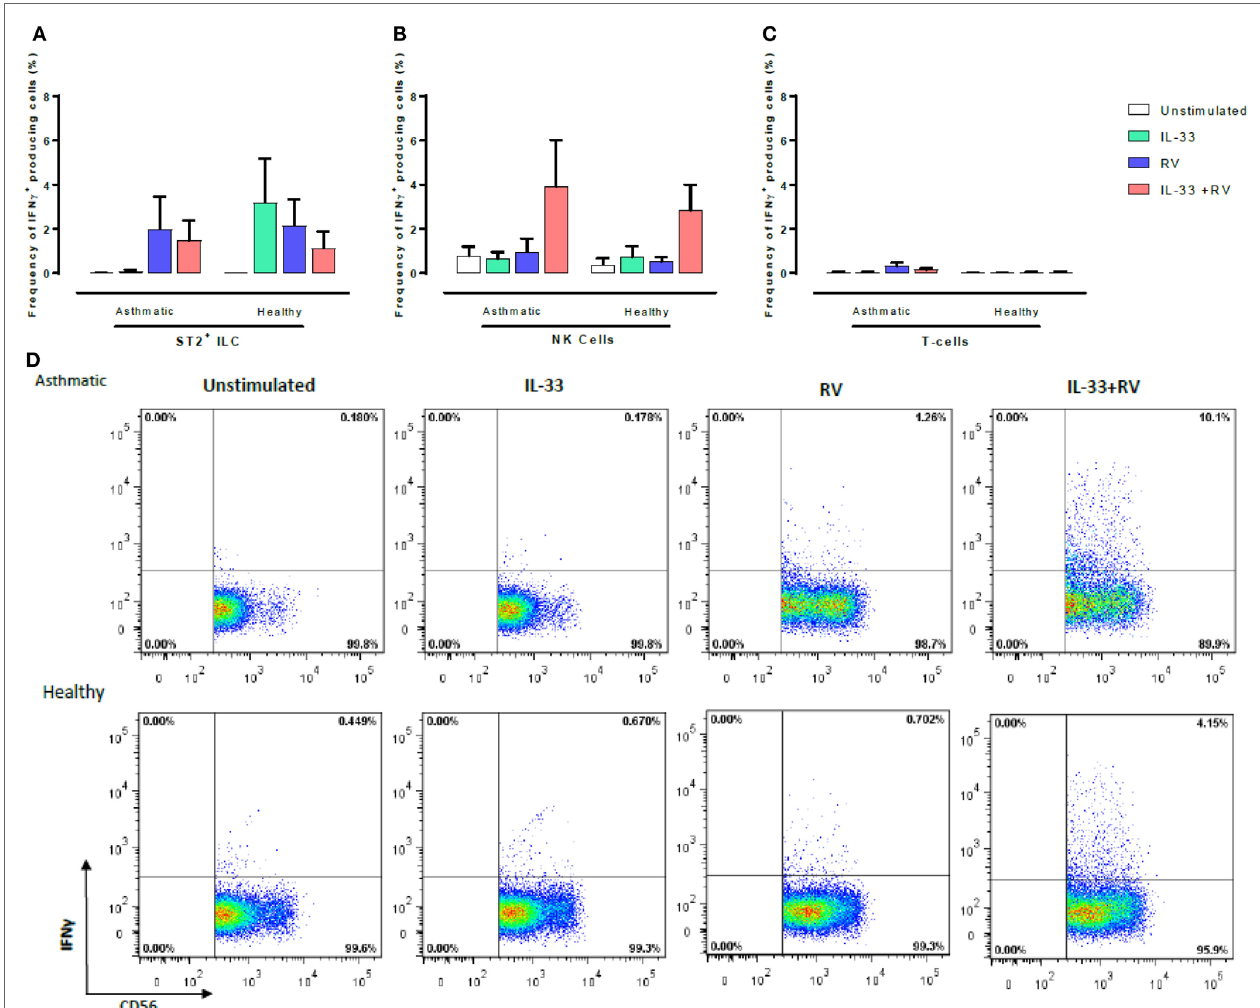
FigUre 4 | Evaluation of IFN γ -producing ST2 + ILC, CD56 + , and CD3 + T cells in human PBMC. IFN- γ -producing cell subsets were evaluated using flow cytometry (a–c) . Raw dot plots representative of IFN- γ + CD56 + cells from 8 asthmatic and 6 healthy donors. PBMCs from people with allergic asthma and non-allergic healthy controls were pre-exposed to media or IL-33 for 6 h and then cultured in the absence or presence of RV for 5 days (D) . Abbreviations: PBMC, peripheral blood mononuclear cells; IL-33, interleukin 33; RV, rhinovirus 16; ST2 + ILCs, ST2 + innate lymphoid cells. * p ≤ 0.05 and ** p ≤